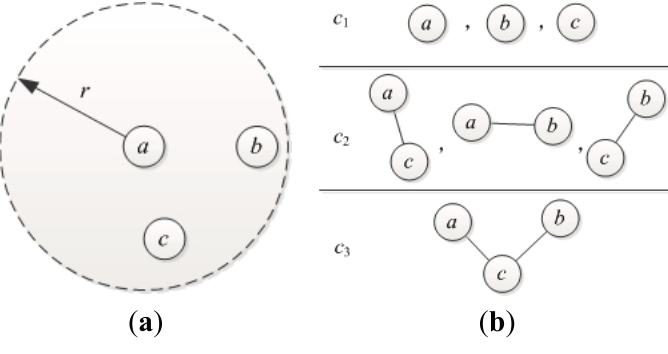
Figure 3. An example of clique types for a wireless sensor network. ( a ) A wireless sensor network with three nodes; ( b ) Three different clique types: single-node, pair-node and triple-node